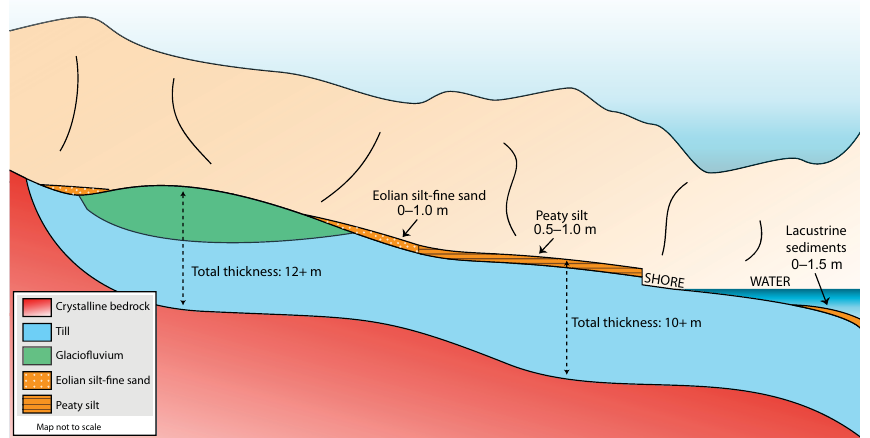
Figure 6. Schematic model and presentation of the sediment thickness from the lake (right) towards higher elevations (left) in a cross section through the valley. Sediment classes and its visual assignment are based on Fig.